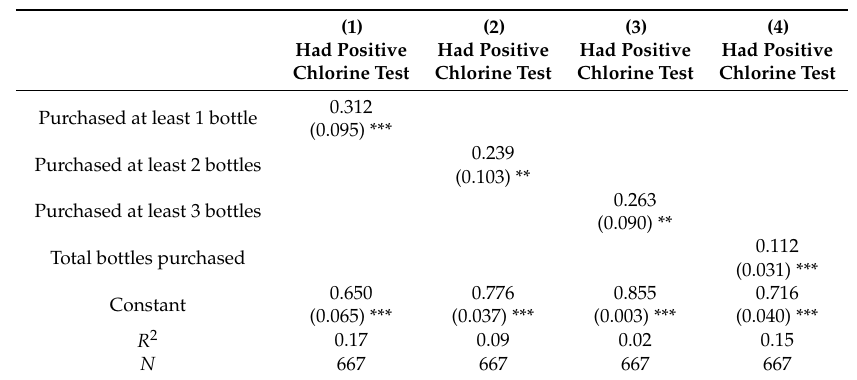
Table 2. Relationship between chlorine purchase and chlorine